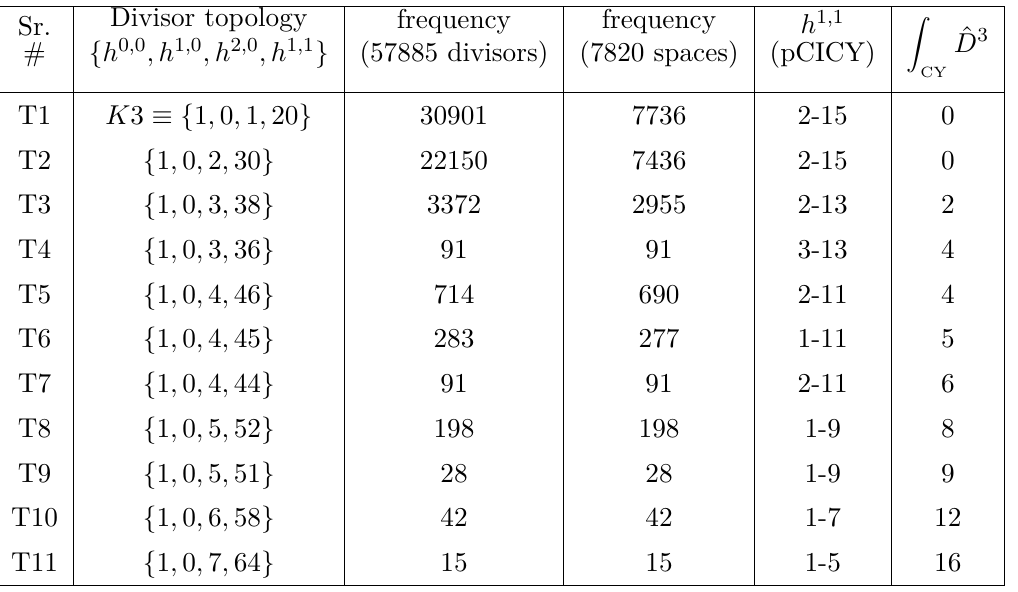
Divisor topologies for favorable pCICYs and their frequencies of appearance, as we discussed in